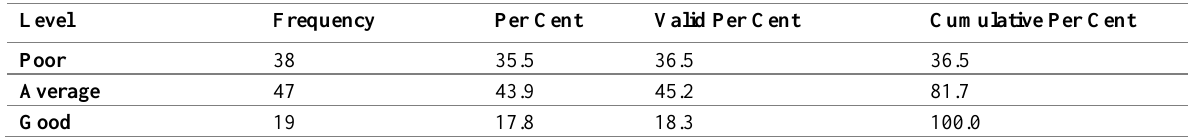
Table 4: Level of